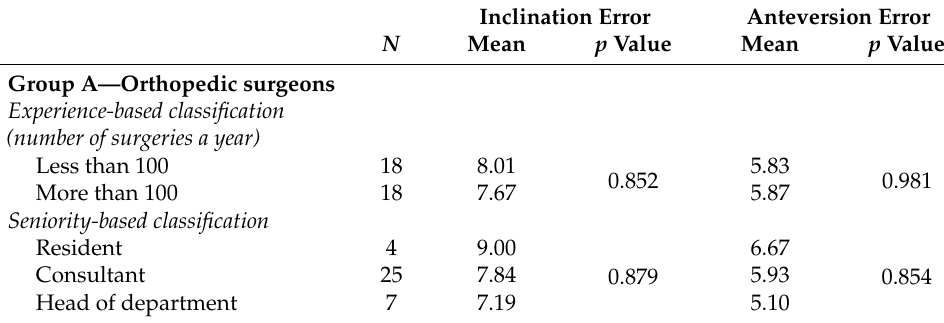
Table 4. Mean errors according to position and